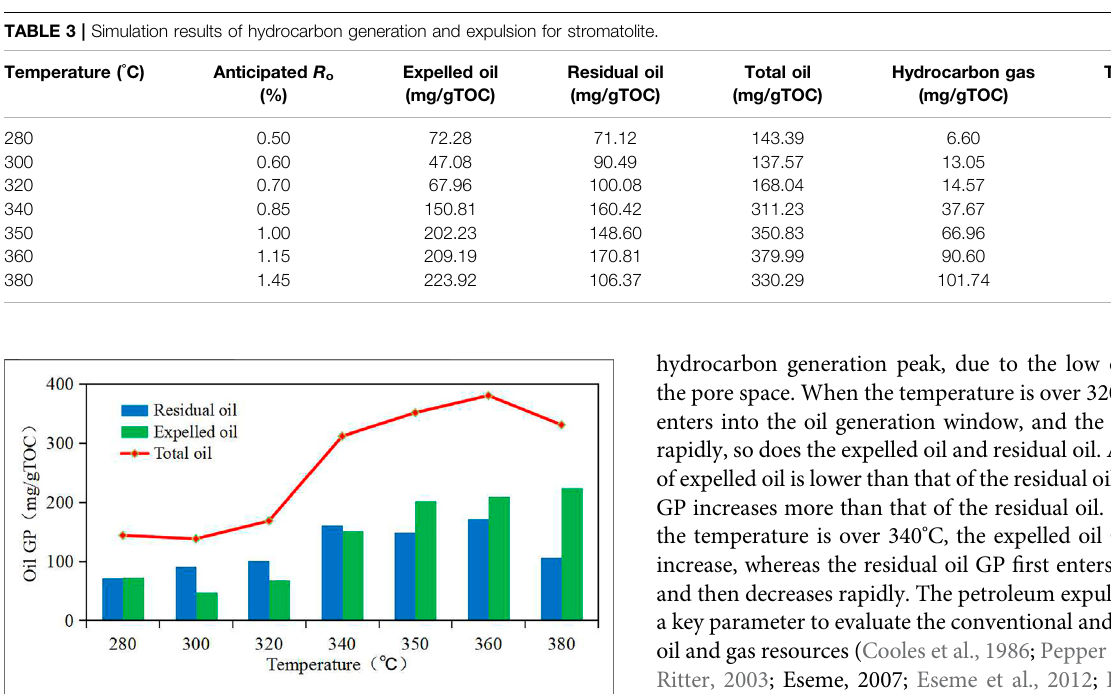
Frontiers in Earth Science |